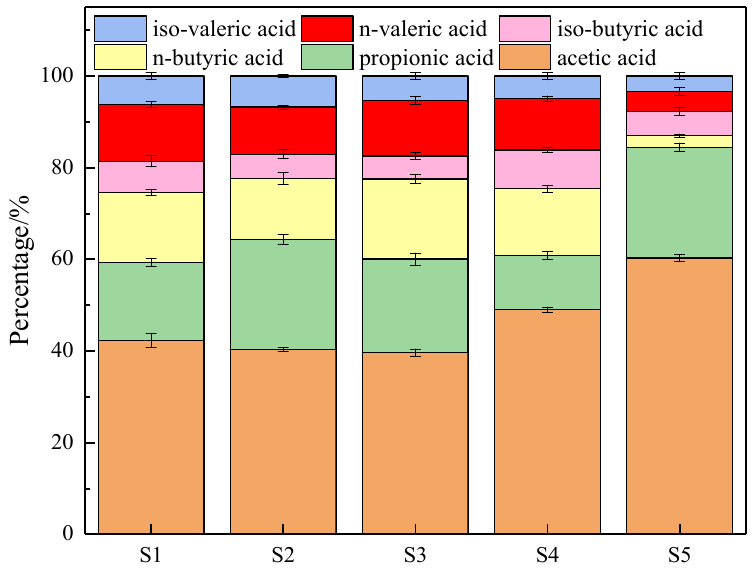
Figure 3. The proportion of six acids on the day of maximal VFA accumulation during digestion. After 5 days of digestion, EPS all decreased (Figure 1c,d). EPS values of each group were 189.39 mg/L, 166.14 mg/L, 145.92 mg/L, 227.105 mg/L, and 213.37 mg/L, respectively. Compared with 5 days before, they had decreased by 41.75%, 64.75%, 71.06%, 80.92%, and 83.95%, respectively. Among them, most of the S-EPS and LB-EPS were degraded. As a necessary substance for acid production, the concentration of EPS decreased the most after alkaline ferrate pretreatment (S5), with a decrease of 83.95%, which also suggested that the acid production effect of this group was better. 3.2.2. Solid Phase Analysis of Sludge during Digestion After 5 days of digestion, the solid phase of the sludge changed (Table 4). Compared with the original sludge concentration, the VSS of the five groups decreased by 15.25%, 15.79%, 19.64%, 26.89%, and 29.45%, respectively, after 5 days of digestion. Compared with before digestion, SV 30 in all five groups increased and SVI of all five groups increased too (from 83.60 mL/g to 139.3 mL/g, from 81.49 mL/g to 143.1 mL/g, from 77.87 mL/g to 165.2 mL/g, from 79.43 mL/g to 155.3 mL/g, and from 78.8 mL/g to 168.3 mL/g), which may be because the hydrolysis of the macromolecular solid into an insoluble macromo- lecular solid increased the volume of the solid phase. In addition, after pretreatment with ferrate (S4, S5), SVI increased the most, which may be because iron played a role in phos- phorus removal during digestion, and flocculation declined. After 5 days of digestion, the Dx (50) of each group of data tended to be consistent. It can be seen that the unhydrolyzed and acidified parts of the crushed sludge gradually gather again during digestion, which may be due to the flocculation of iron and the secretion of viscous substances by microor- ganisms [42]. Table 4. Solid-phase changes of excess sludge after digestion. Parameters S1 ′